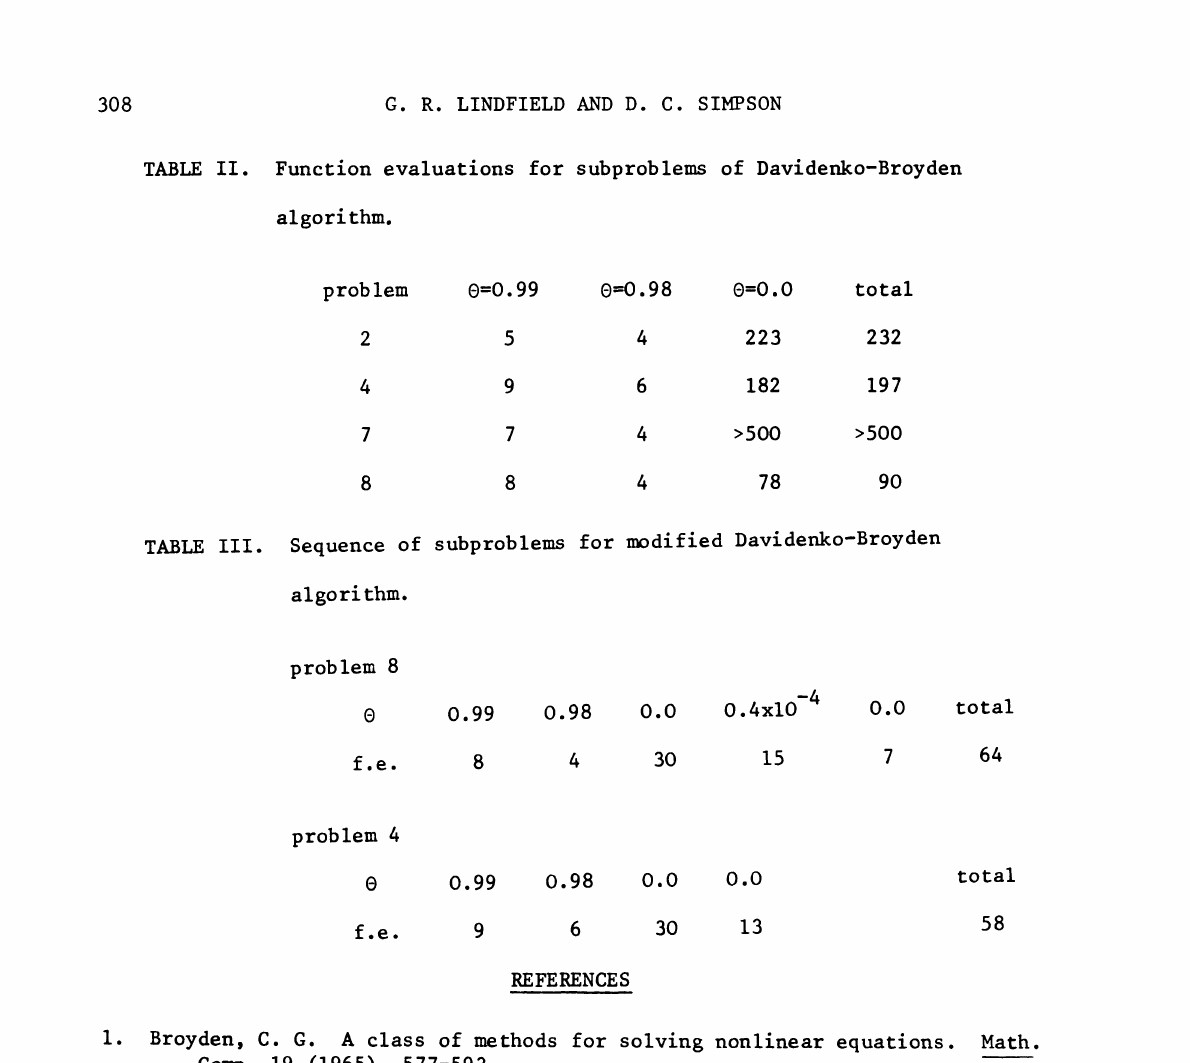
TABLE II. Function evaluations for subproblems of Davidenko-Broyden algorithm.